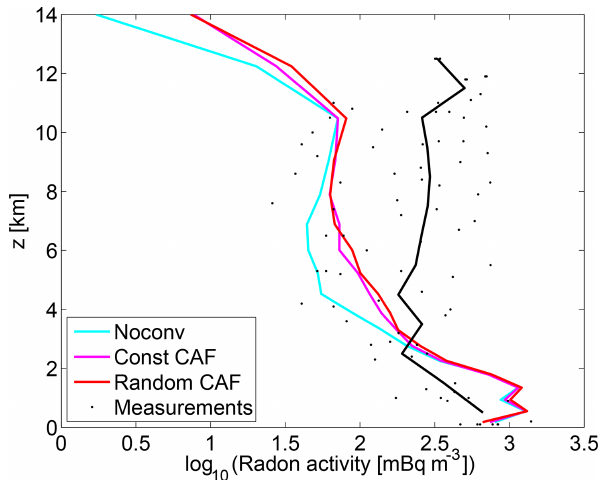
Figure 16. Observed radon from aircraft measurements of the Mof- fett Field campaign (California) in June 1994 (Kritz et al., 1998) compared to the simulated radon from our model in the same time period using a bounding box including all measurements. Dots show the single measurements and the solid black line the mean in 1km bins.